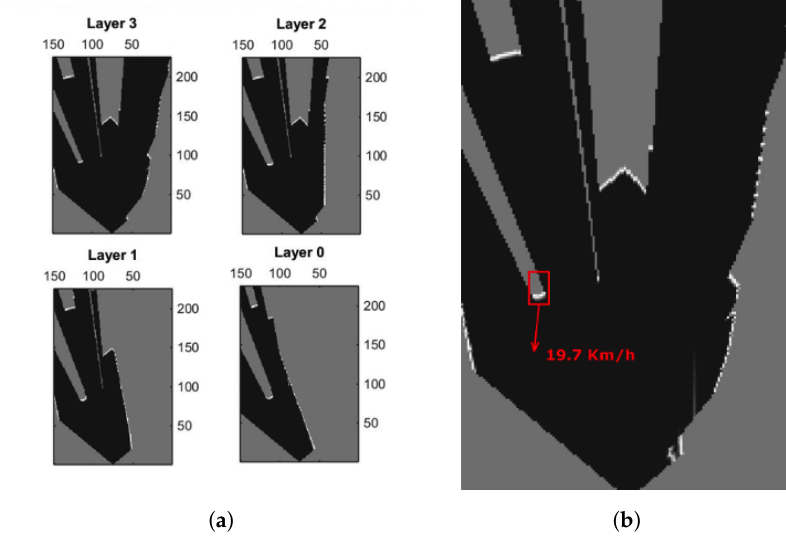
Figure 2. ( a ) Probabilistic occupancy map for each LiDAR layer, ( b ) integrated occupancy map. Dark areas represent empty space, white areas represent objects/occupied parts and unknown regions are in